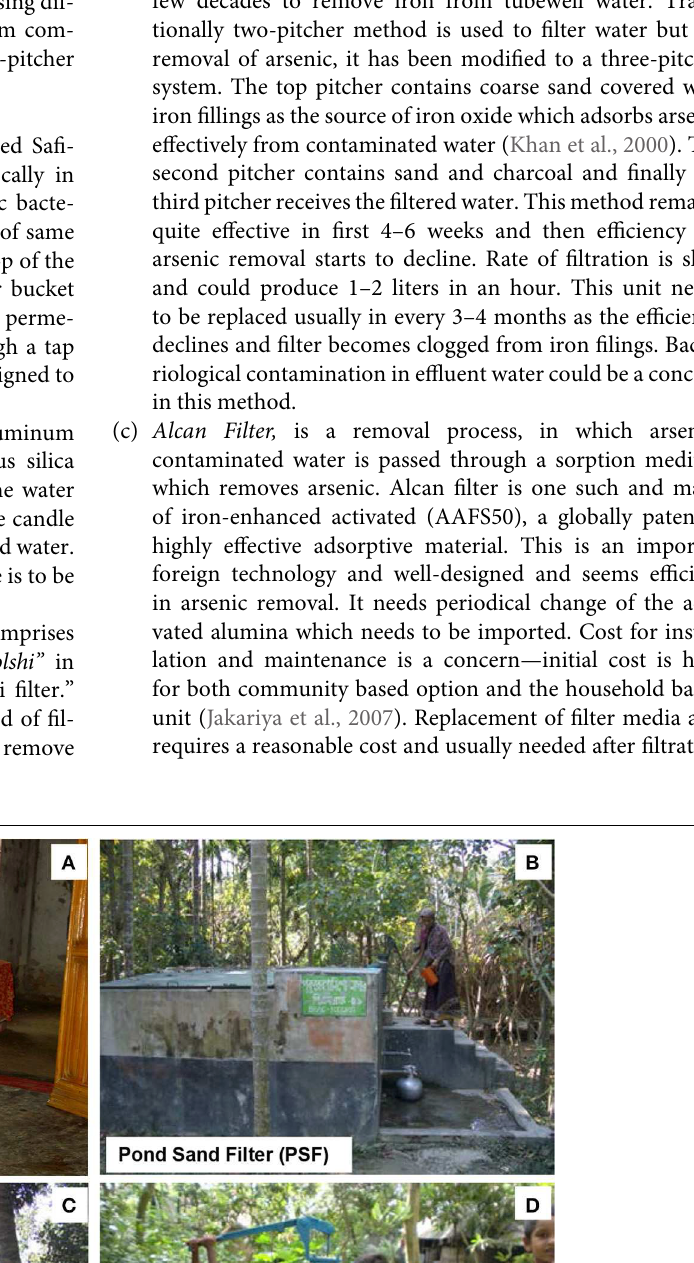
Frontiers in Environmental Science |